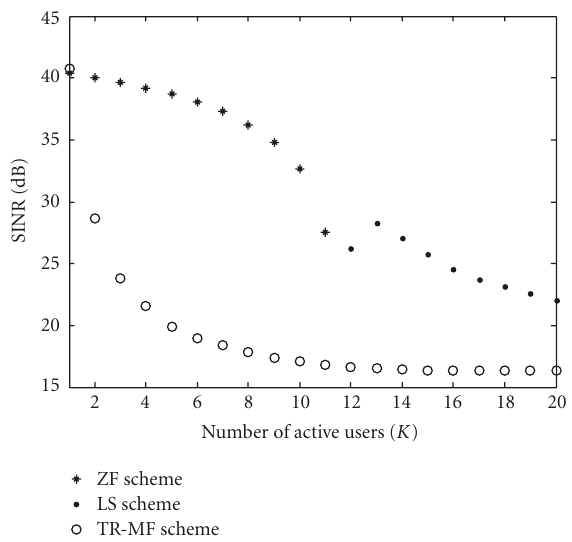
Figure 5: SINR performance with respect to the number of active